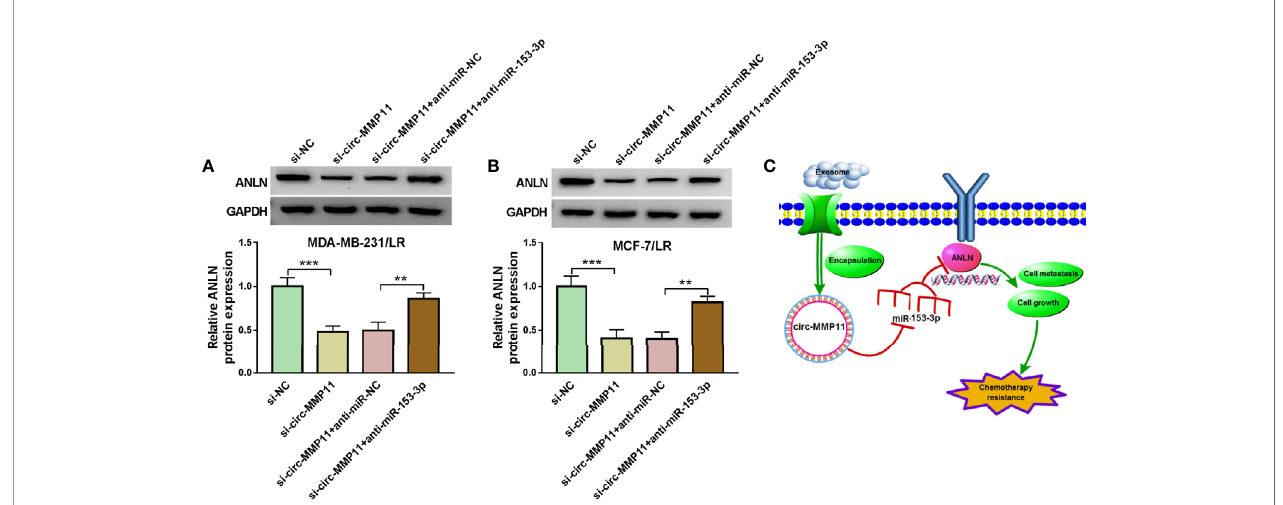
FIGURE 8 | Circ-MMP11 could regulate ANLN expression by sponge miR-153-3p. (A, B) ANLN protein level was detected in MDA-MB-231/LR and MCF-7/LR cells transfected with si-NC, si-circ-MMP11, si-circ-MMP11 + anti-miR-NC, and si-circ-MMP11 + anti-miR-153-3p. (C) Exosomal circ-MMP11 could promote chemotherapy resistance by regulating cell growth and metastasis via the miR-153-3p/ANLN axis. ** P < 0.01, *** P < 0.001 (ANOVA with Tukey ’ s tests), ANLN relative to